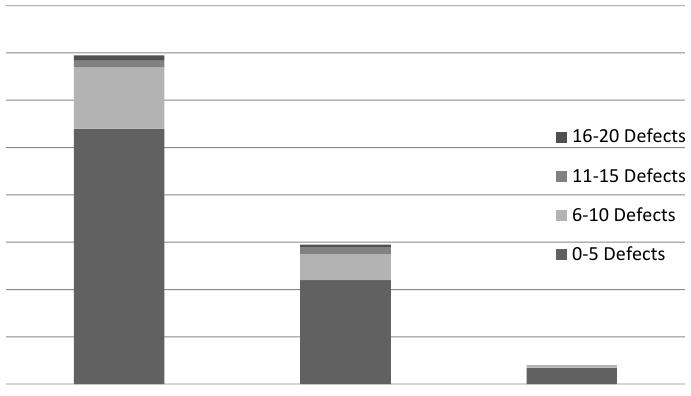
Figure 3. Home owners’ stage of involvement and number of defects.